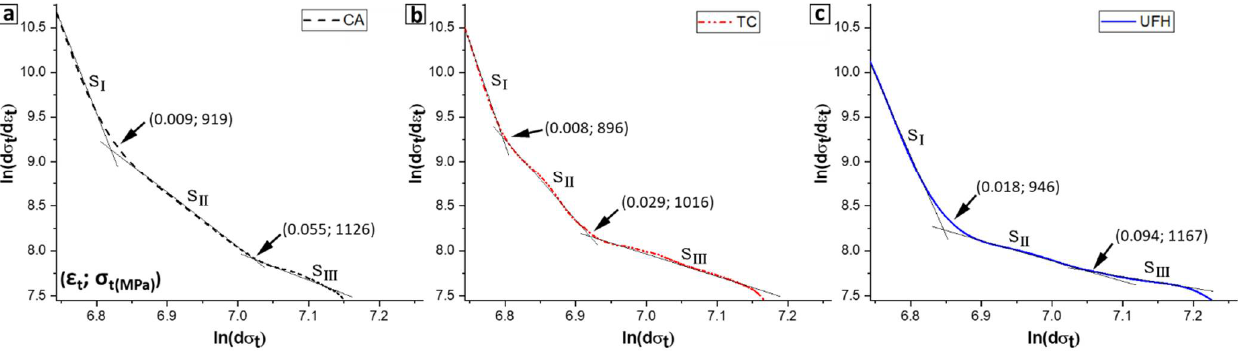
Figure 12. Strain hardening behavior plotted according to the modified C-J analysis in samples ( a ) CA, ( b ) TC and ( c ) UFH. Values indicated in parenthesis at the inflection points of the strain hardening curves correspond to the true strain and true stress, respectively (true strain; true stress).